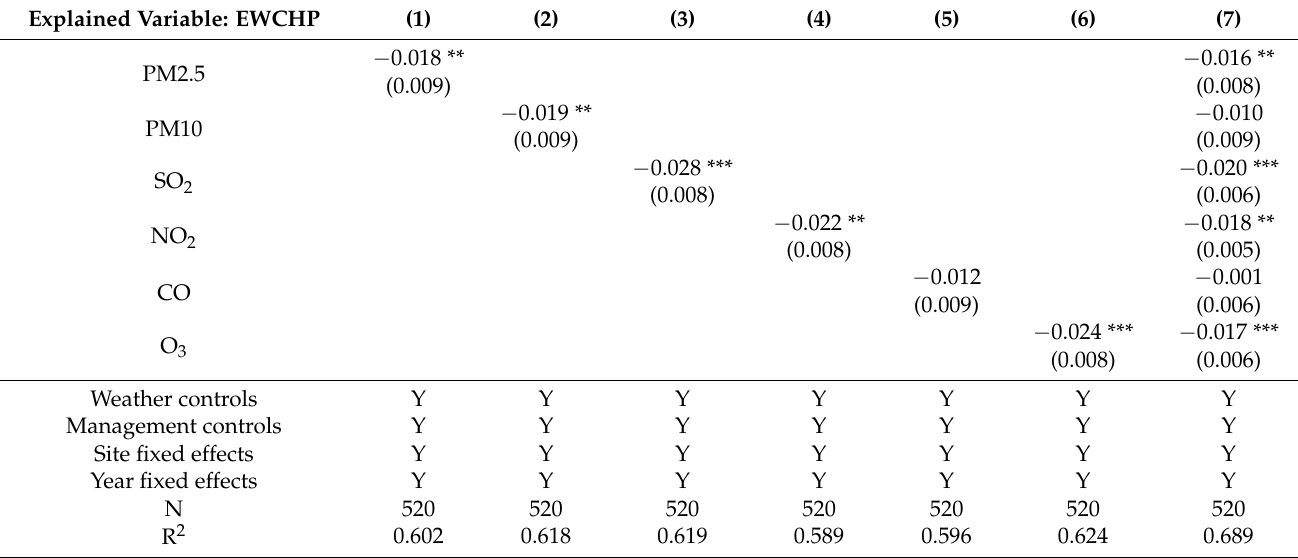
Table 2. OLS Estimations of the impact of air pollution on cultural heritage